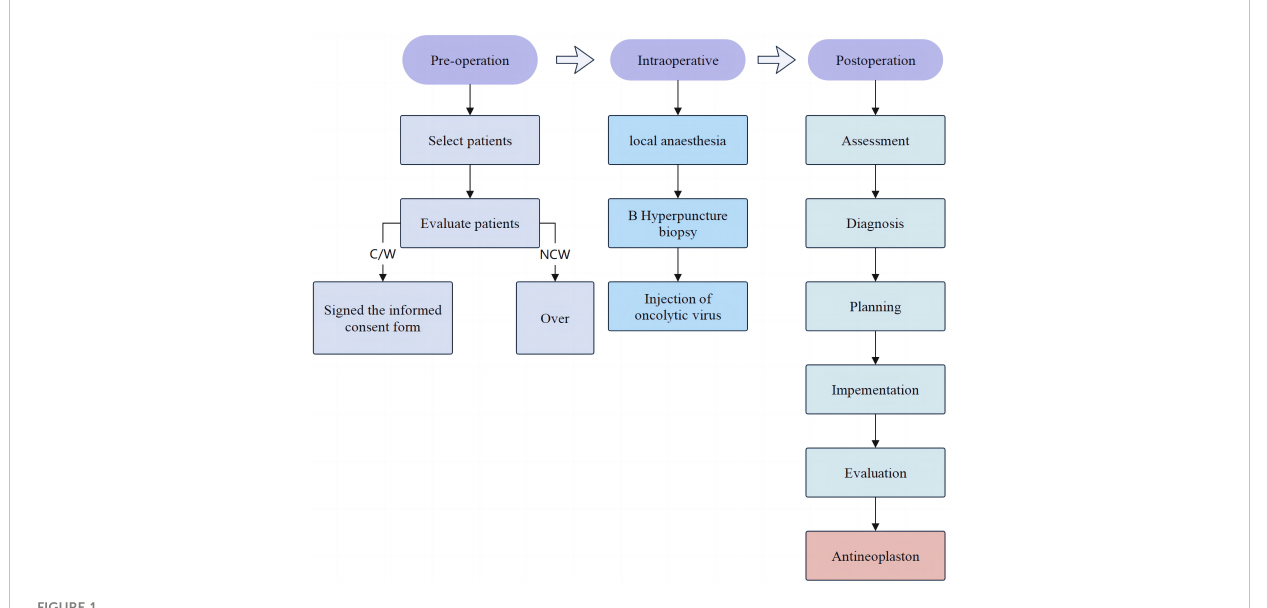
FIGURE 1 Flow diagram of the study